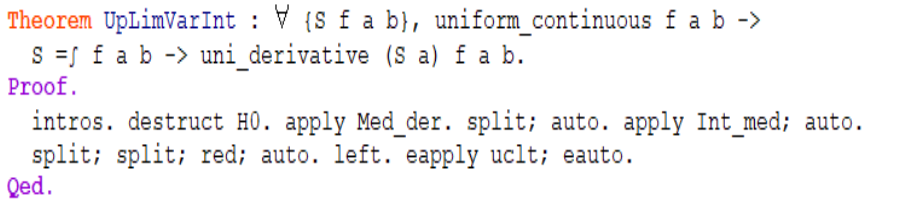
Figure 2. The formalization of differentiability of upper limit-variable